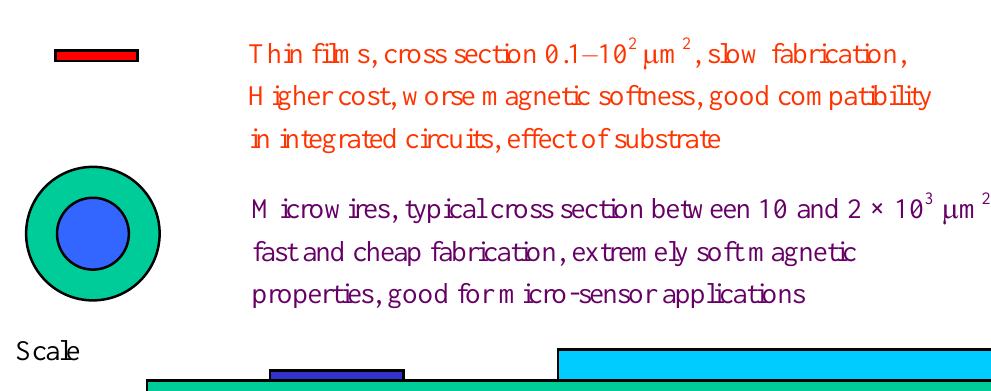
Figure 1. Scheme illustrating comparison of microwires with other soft magnetic materials [34]. Comparison of microwires with other amorphous soft magnetic materials Ribbons, Cross section above 5 × 10 3 m 2 , fast and cheap fabrication, extremely soft magnetic properties, too big for microsensors applications Wires, cross section above 10 3 m 2 , fast and cheap fabrication, good magnetic properties, effect of sample Length ― too big for microsensors applications Thin films, cross section 0.1–10 2 m 2 , slow fabrication, Higher cost, worse magnetic softness, good compatibility in integrated circuits, effect of substrate Microwires, typical cross section between 10 and 2 × 10 3 m 2 , fast and cheap fabrication, extremely soft magnetic properties, good for micro-sensor applications Scale